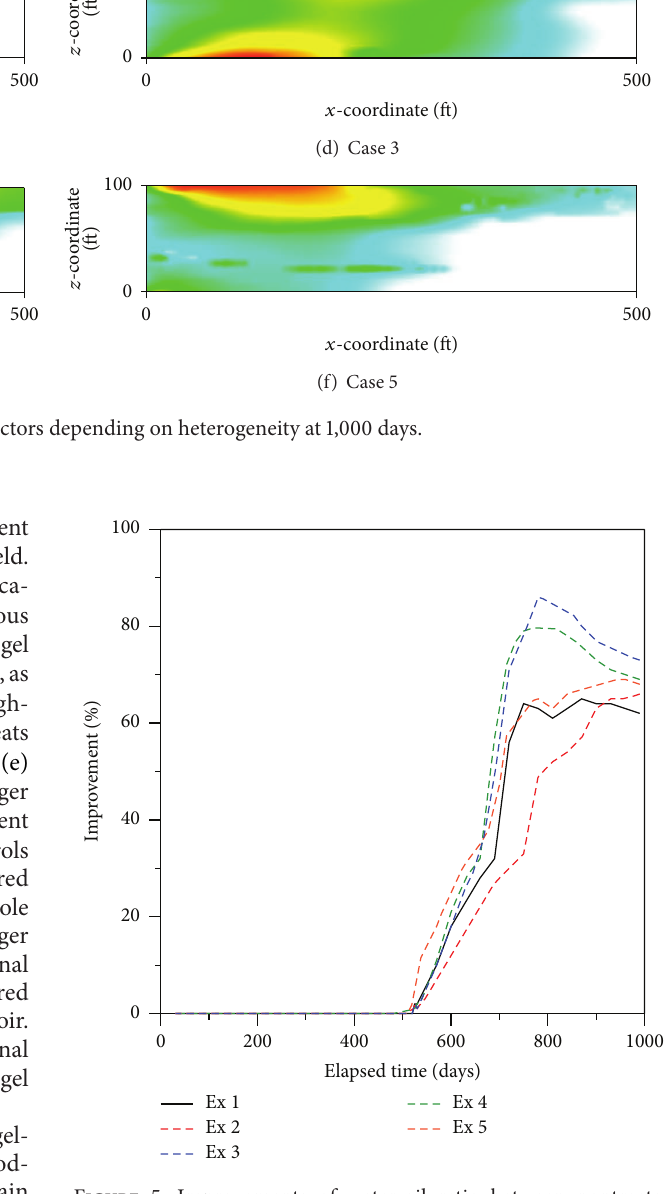
Figure 5: Improvements of water-oil ratio between nontreated waterflooding and gel-treated waterflooding according to elapsed